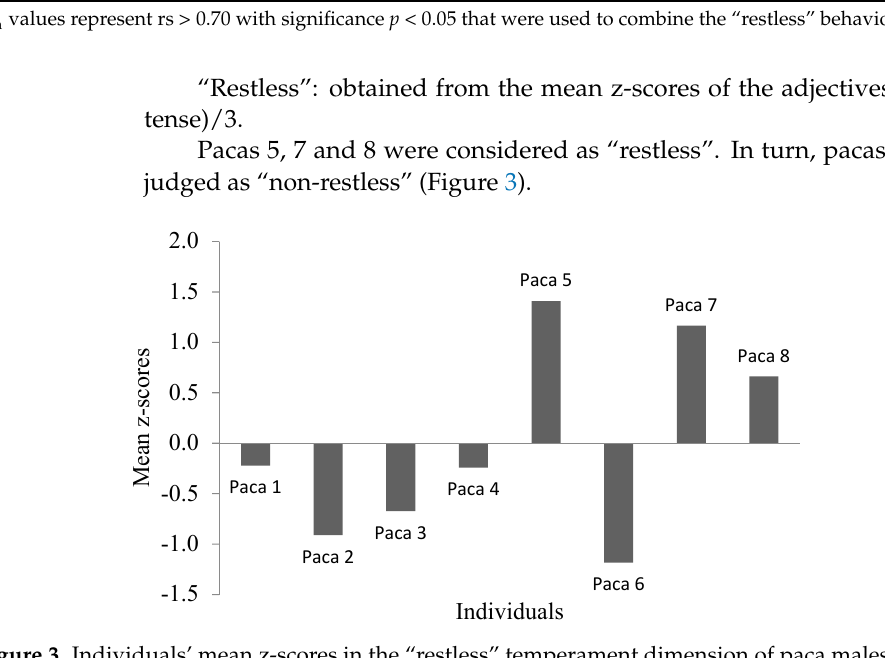
Figure 3. Individuals’ mean z-scores in the “restless” temperament dimension of paca males ( n = 8).